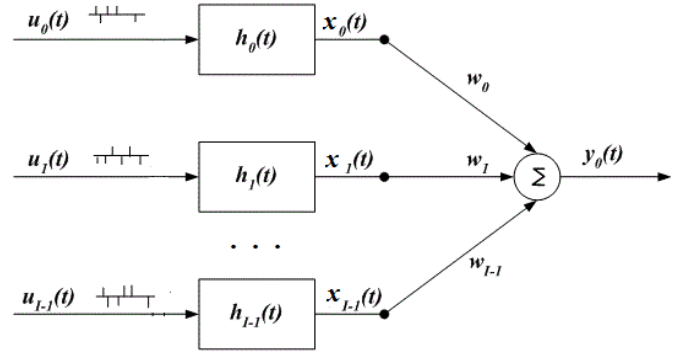
Fig. 1. The multi-input pulsed